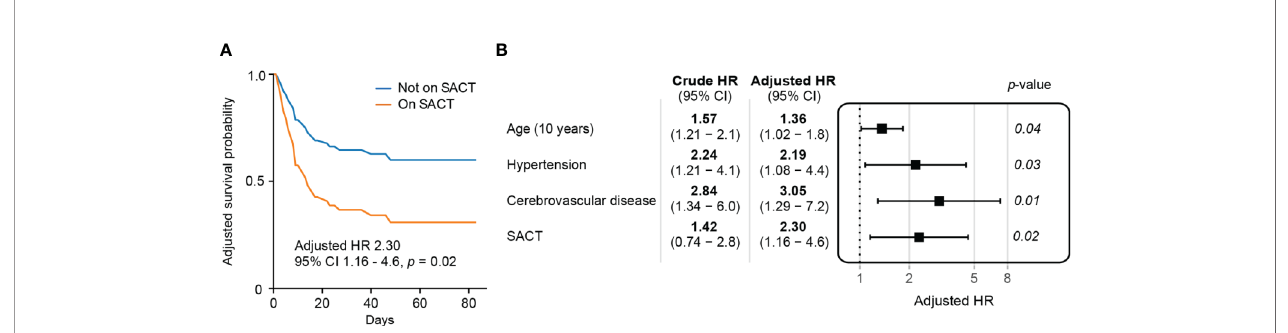
FIGURE 3 | Assessing recent systemic anti-cancer therapy (SACT) as a predictor of mortality following COVID-19 (A) Adjusted survival curves of patients on systemic anti-cancer therapy with COVID-19. (B) Multivariate survival analysis of pre-morbid risk factors in patients with cancer TABLE 2 | Multivariate survival analysis comparing recent types of anti-cancer treatment in patients with cancer and COVID-19, adjusted for age and co- morbidities (hypertension and cerebrovascular disease). HR (95% CI) p -value All systemic anti-cancer therapy